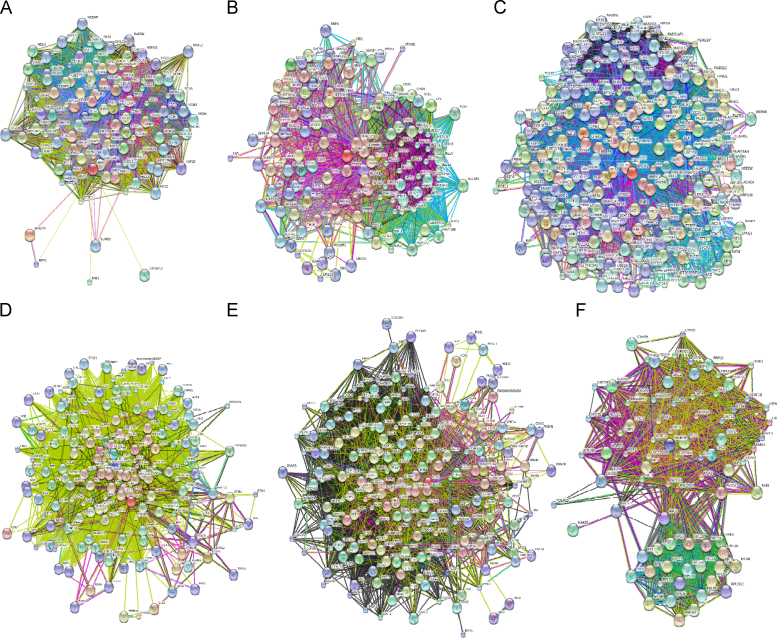
Analysis of the interactivity of the several human nuclear proteins by the STRING platform [58]. Analyzed proteins are: (A) KI-67 (UniProt ID: P46013), (B) N-CoR2 (UniProt ID: Q9Y618), (C) BRCA1 (UniProt ID: P38398), (D). SON (UniProt ID: P18583), (E) ATRX (UniProt ID: P46100), and (F) RLP24 (UniProt ID: Q9UHA3). STRING produces the network of predicted associations for a particular group of proteins. The network nodes are proteins, whereas the edges represent the predicted or known functional associations. An edge is drawn with up to 7 differently colored lines that represent the existence of the seven types of evidence used in predicting the associations. A red line indicates the presence of fusion evidence; a green line – neighborhood evidence; a blue line – co-occurrence evidence; a purple line – experimental evidence; a yellow line – text mining evidence; a light blue line – database evidence; a black line – co-expression evidence [58].